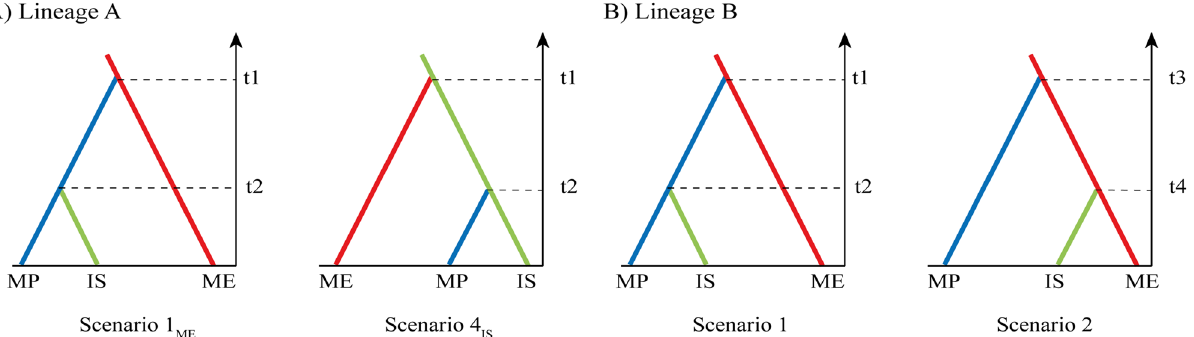
Figure 2. Colonization scenarios tested using DIYABC v2.1 in ( A ) lineage A and ( B ) lineage B of domestic sheep. Colours represent the populations: ME (the Middle East, red), MP (the Mongolian Plateau, blue) and